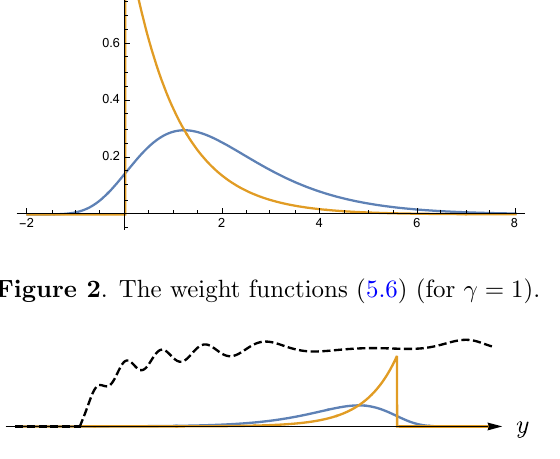
Figure 3 . An intuitive illustration, see the text. Notice that (cid:26) ( x ) vanishes for x < log (cid:1)